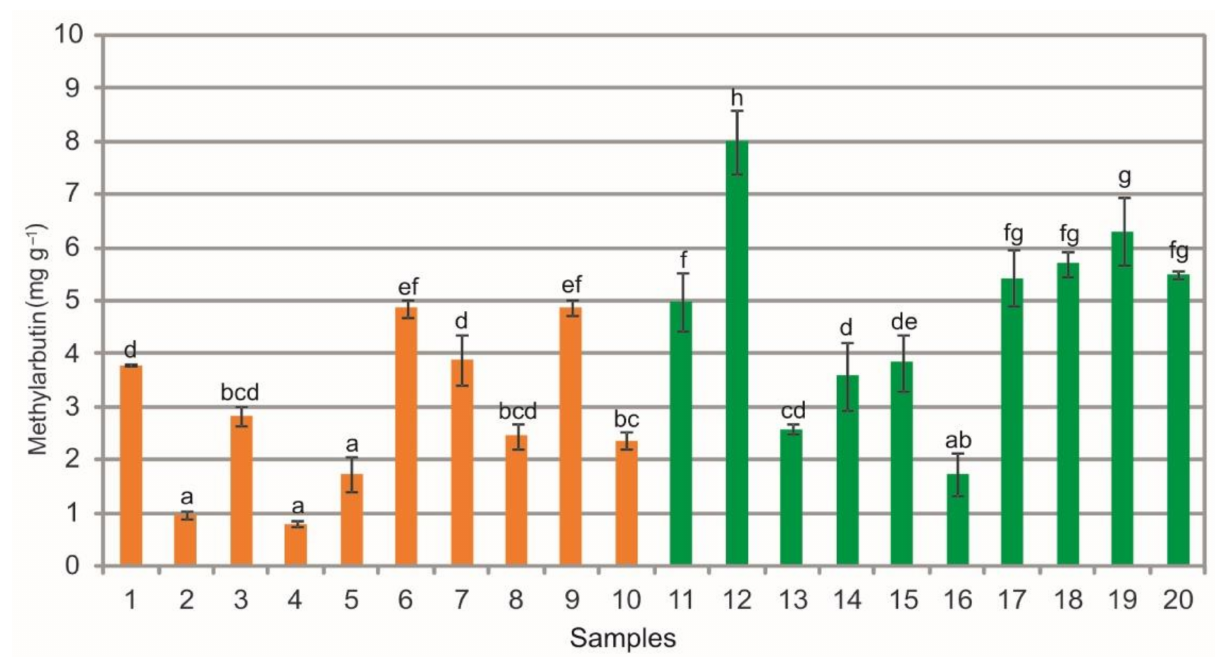
Figure 4. Methylarbutin contents (mg g − 1 ) in leaf extracts from bearberry plants collected in heathland populations (orange) and in pine forest populations (green). For each site, data are mean and SD. The values designated by the different letters are significantly different (Tukey test, p <